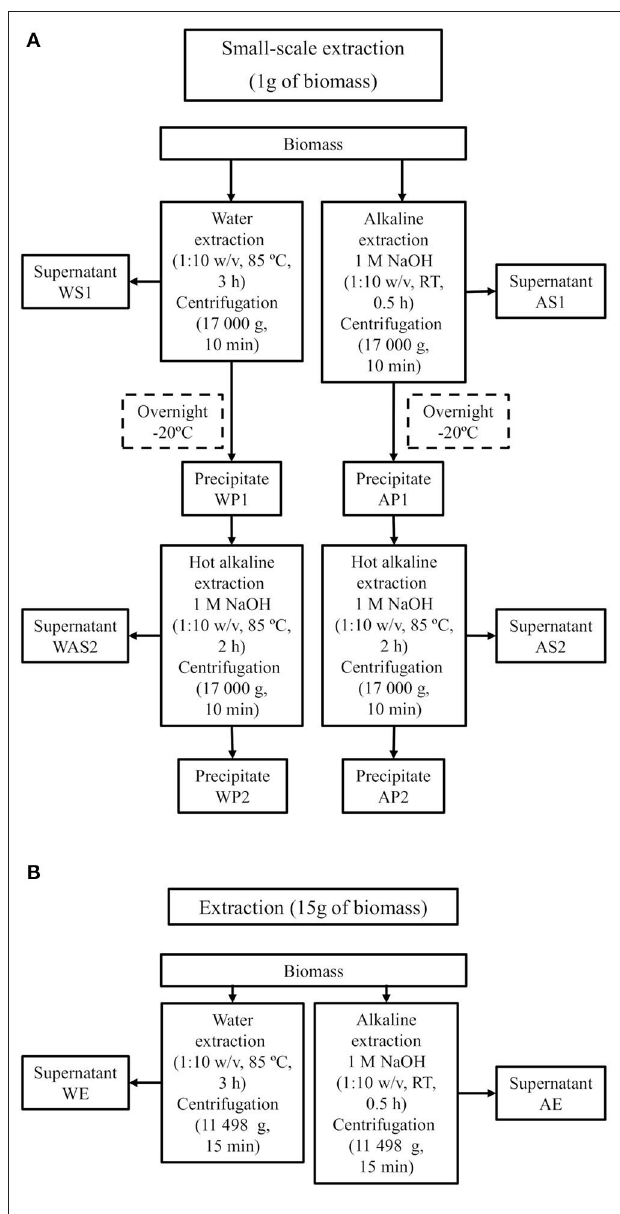
FIGURE 1 | Extraction scheme of water and alkaline extraction of biomass in small-scale (A) and larger scale (B) and sample codes for each